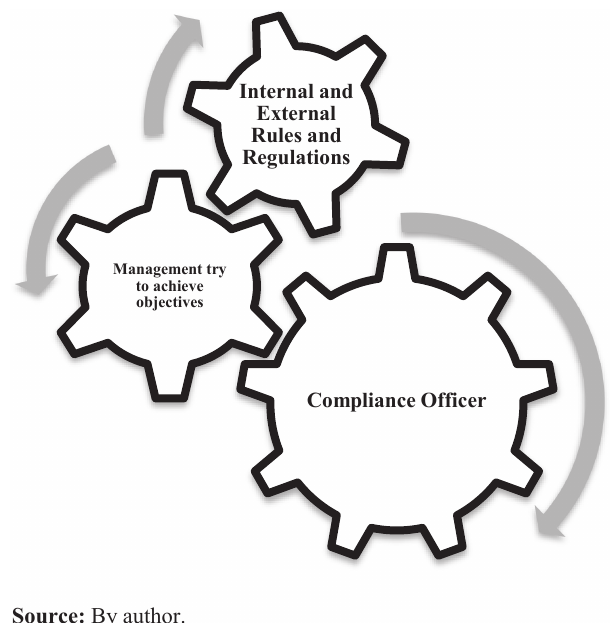
Figure 1. The evolving role of compliance